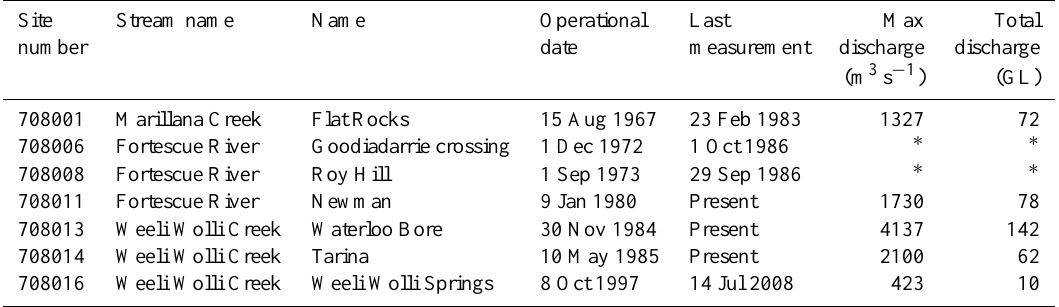
Table A1. Temporal coverage of all official stream gauging stations in the upper Fortescue River catchment and maximum recorded daily discharge.